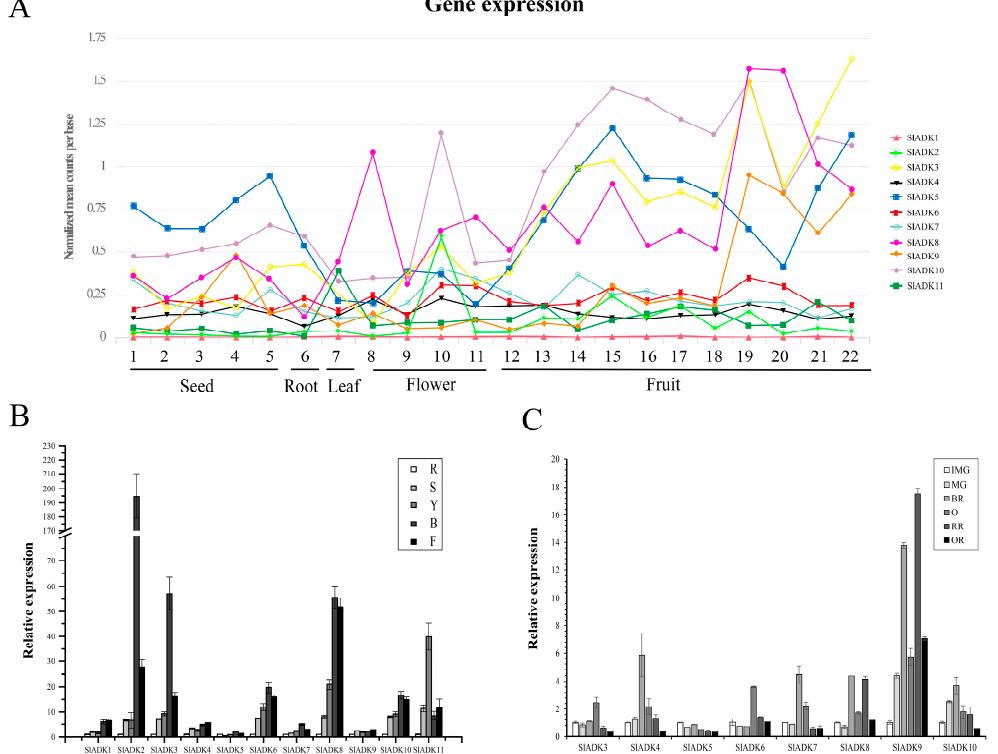
Figure 5. Expression patterns of the SlADK genes in different tissues. ( A ) Expression patterns of the SlADK genes in various tissues obtained from the TomExpress platform. 1, whole seed of immature green fruit (10 day post anthesis, DPA); 2, whole seed of mature green fruit (35 DPA); 3, whole seed of breaker fruit (38 DPA); 4, whole seed of orange fruit (41 DPA); 5, whole seed of red fruit (44 DPA); 6, whole root; 7, whole leaf; 8, petal of flower; 9, whole flower in the stage of bud; 10, whole flower in the stage of bud at 3 mm; 11, whole flower in the stage of anthesis; 12, whole fruit in the stage of 4 DPA; 13 and 14, flesh and peel of immature green fruit (10 DPA), respectively; 15 and 16, flesh and peel of mature green fruit (35 DPA), respectively; 17 and 18, flesh and peel of breaker fruit (38 DPA), respectively; 19 and 20, flesh and peel of orange fruit (41 DPA), respectively; 21 and 22, flesh and peel of red fruit (44 DPA), respectively. ( B ) Expression of SlADK genes with real-time PCR detection in various tissues including roots (R), stems (S), fully expanded leaves (L), bud (B), and flowers (F). ( C ) Expression of SlADK genes with real-time PCR detection at different stages during fruit development and ripening: immature green (IMG), mature green (MG), breaker (Br), orange (O), red ripe (R), and over-ripe (OR). Quantitative PCR data represent mean values for three independent biological replicates ( n = 3).